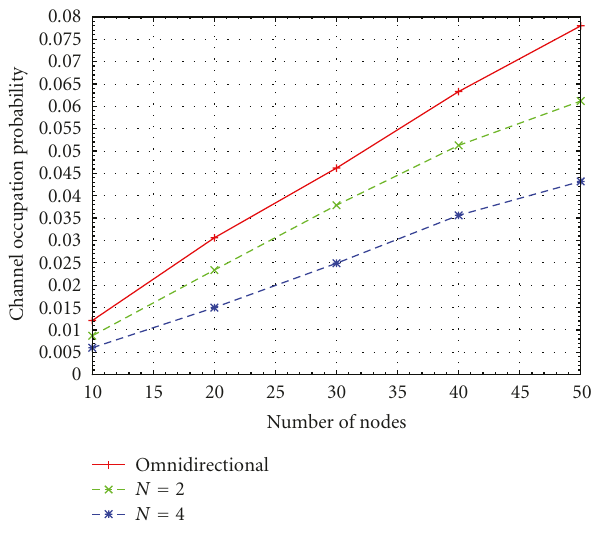
Figure 8: Channel occupation probability as a function of the num- ber of nodes in the case of omnidirectional and directive antennas with π and π/ 2 main lobes for T f = 93seconds and δ =